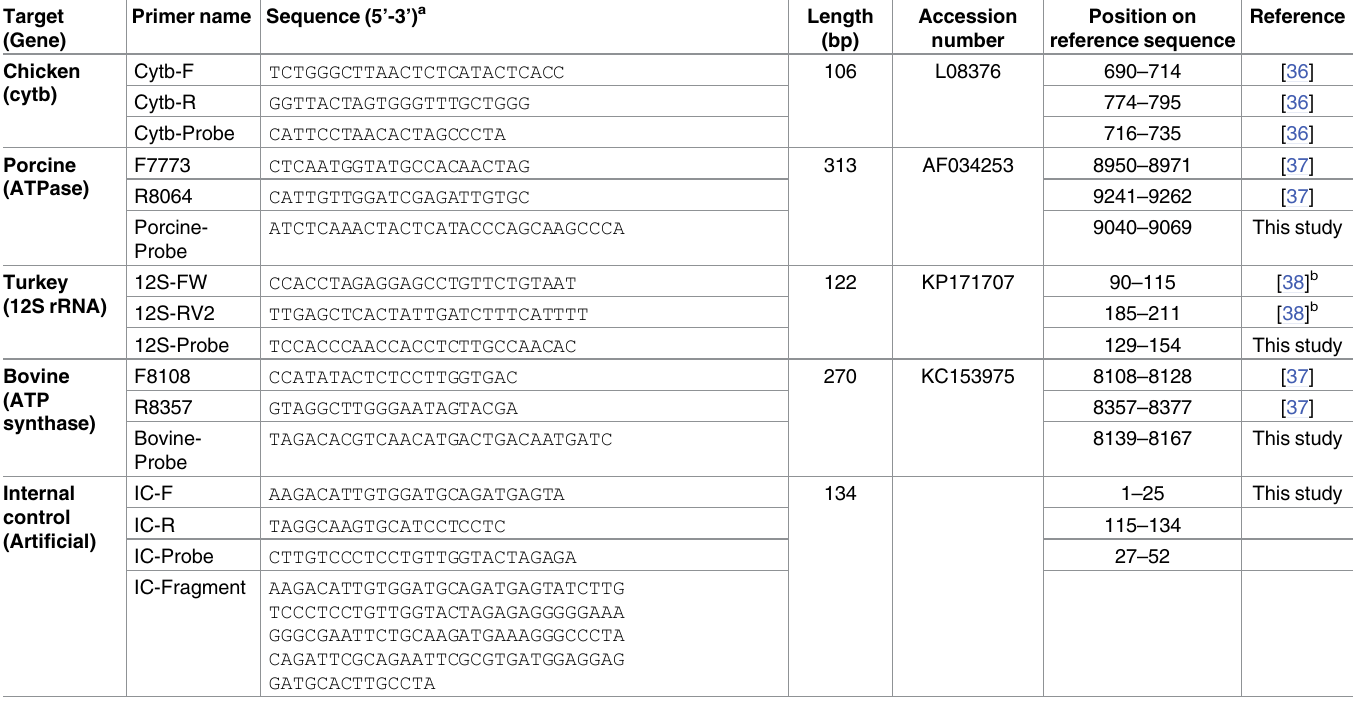
Table 1. Primers and probes used for ddPCR assaysin this